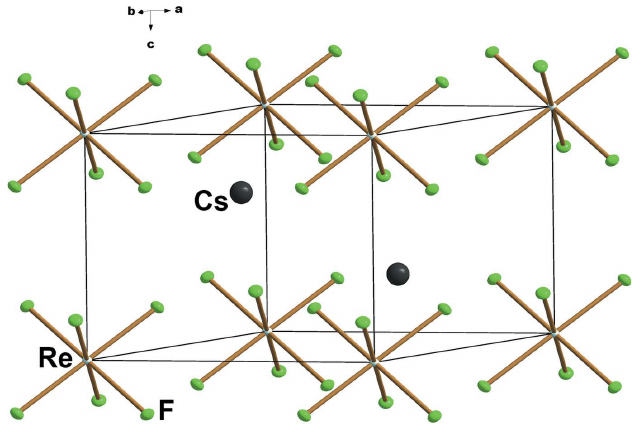
Figure 2 A packing diagram of Cs 2 [ReF 6 ]. Displacement ellipsoids are drawn at the 50% probability level.